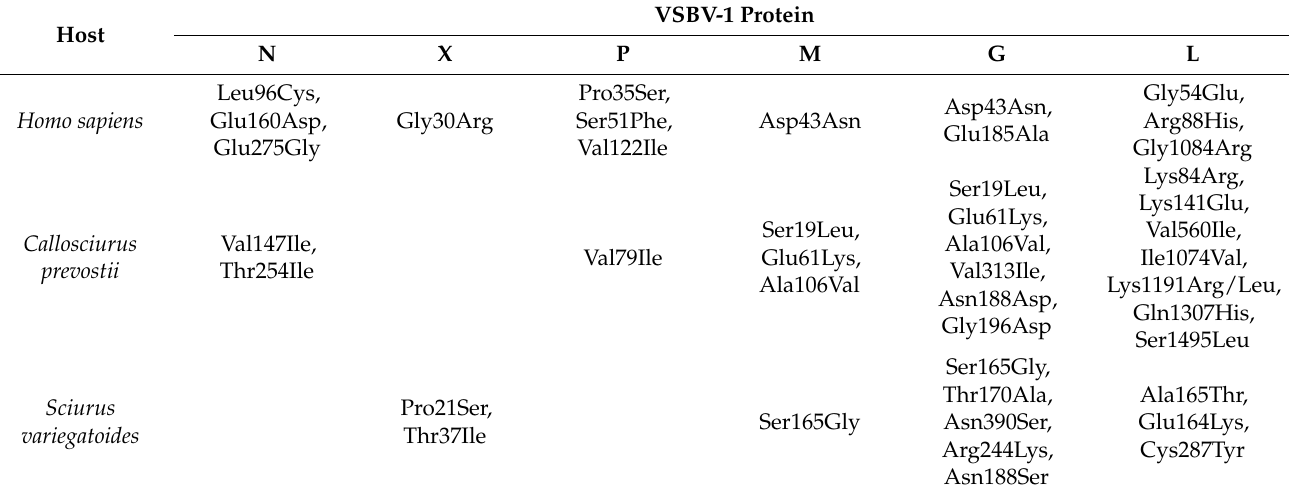
Table 1. Host-specific non-synonymous substitutions among VSBV-1